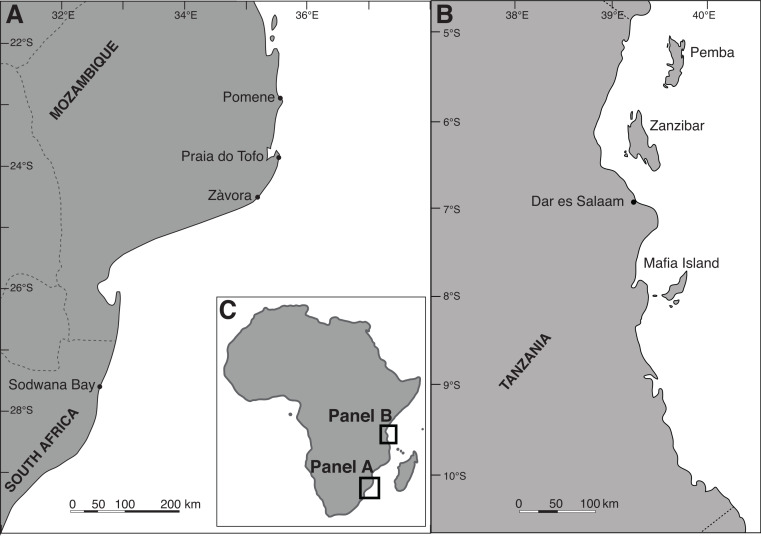
Maps of the study locations.The study locations off (A) Praia do Tofo in southern Mozambique and (B) Mafia Island in Tanzania, with (C) an inset of Africa for overview.